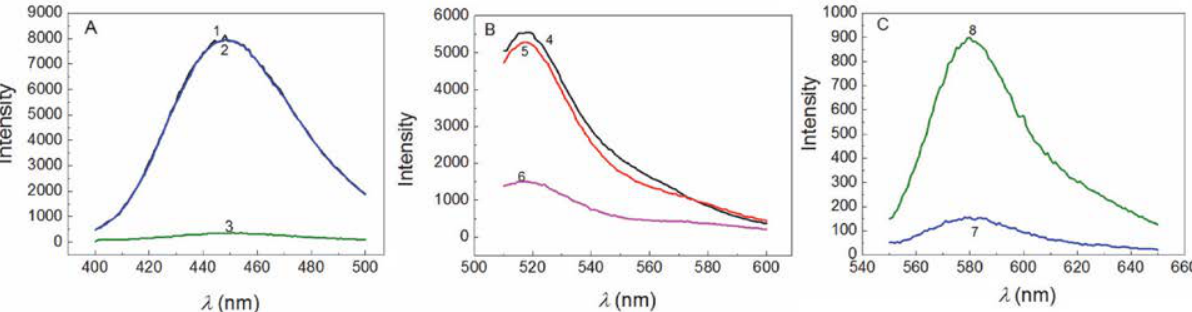
Fig. 2. Fluorescence emission spectra of the detection of (A) Pb 2+ ( λ ex = 353 nm, λ em = 450 nm), (B) Ag + ( λ ex = 495 nm, λ em = 517 nm), (C) Hg 2+ ( λ ex = 530 nm, λ em = 580 nm) in the solution containing (1) AuNP-cDNA-dDNA-AMCA, (2) AuNP-cDNA-dDNA-AMCA + AuNP-bDNA, (3) AuNP-cDNA-dDNA-AMCA + AuNP-bDNA + Pb 2+ , (4) FAM-aDNA, (5) FAM-aDNA + AuNP-cDNA, (6) FAM-aDNA + AuNP-cDNA + Ag + , (7) AuNP-RBITC, (8) AuNP-RBITC + Hg 2+